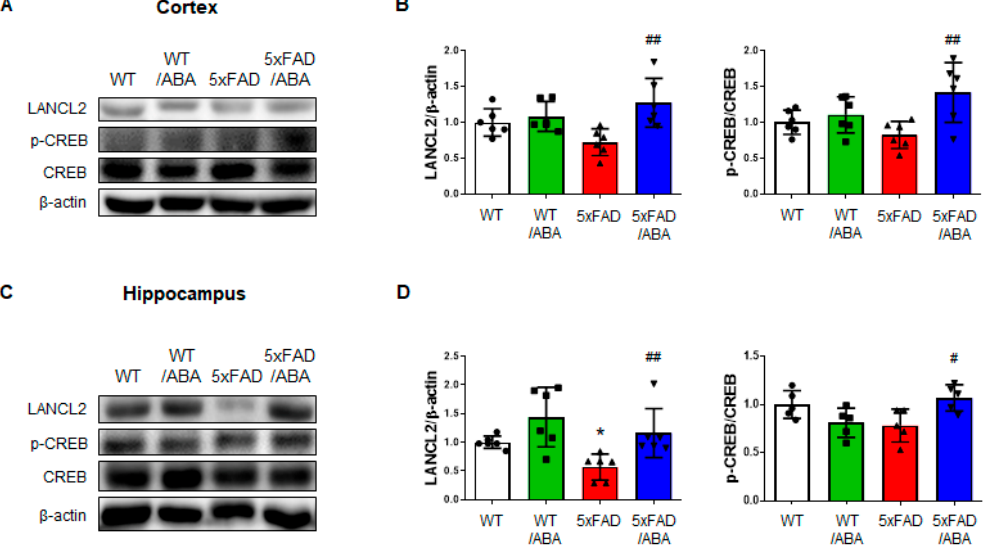
Figure 6. ABA attenuates AD pathologies by activating the LanC-like protein 2 (LANCL2) pathway. ( A ) The representative images and ( B ) quantified protein levels of LANCL2 and cAMP response element-binding protein (CREB) in the cortex. ( C ) The representative images and ( D ) quantified protein levels of LANCL2 and CREB in the hippocampus. All data are expressed as the mean ± S.E.M. ( n = 5–6). Statistics were analyzed by one-way ANOVA with Tukey’s post hoc test. * p < 0.05, significantly different from the vehicle-treated WT group; # p < 0.05, ## p < 0.01, significantly different from the vehicle-treated 5xFAD group.